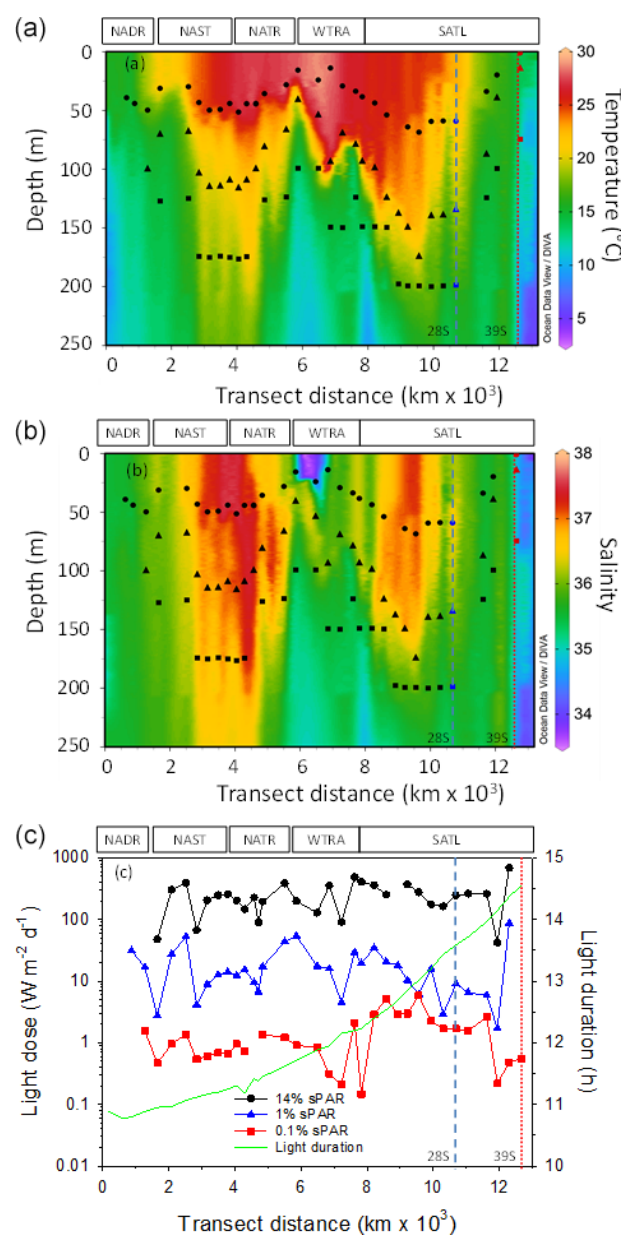
Figure 2. Contour plots of water column temperature (a) and salin- ity (b) measured during CTD-rosette casts. The calculated daily light dose (PAR intensity × light-phase duration) received at sam- pling depths is presented (c) in addition to the duration of the light phase (in hours). The approximate position of Longhurst provinces (defined in Fig. 1) is indicated. Symbols represent 14% sPAR (cir- cle), 1% sPAR (triangle), and 0.1% sPAR (square). The locations of two eddy features are indicated by vertical dashed (28 ◦ S) and dotted (39 ◦ S)